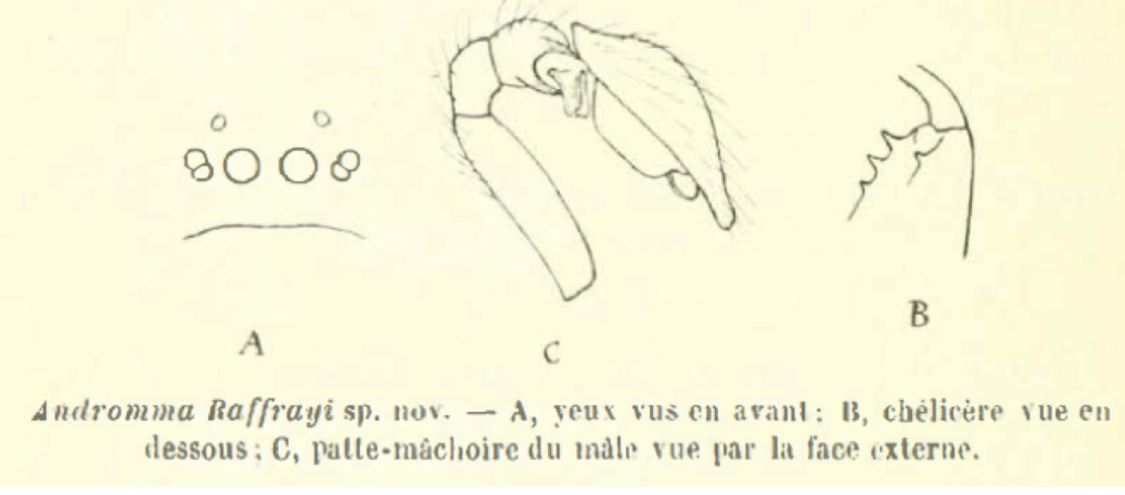
Fig. 32. Andromma raffrayi Simon, 1899. Original drawings and legend from